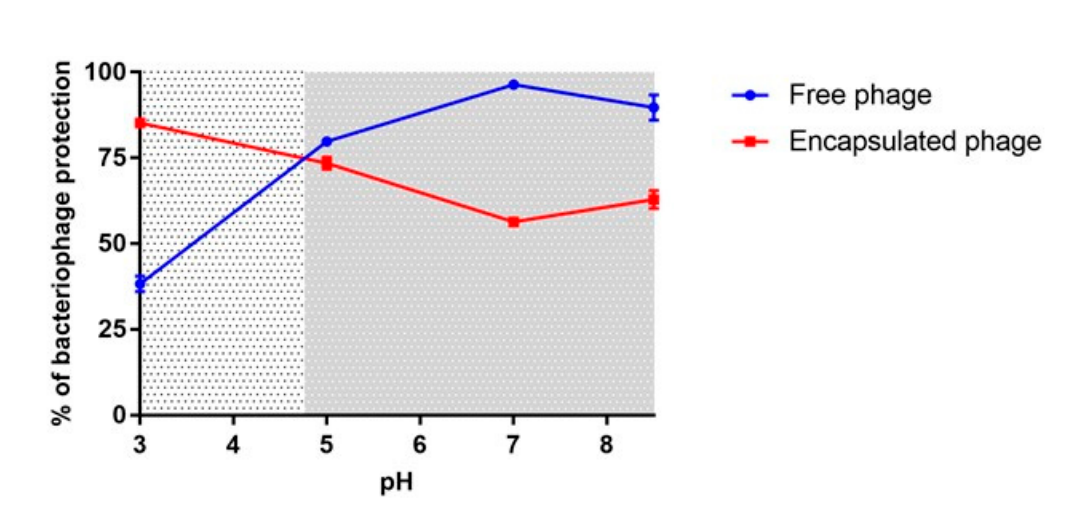
Table 4. Presence and absence of lytic zones of phage S1 in GIT of chickens after ALG beads administration. Section of the GIT